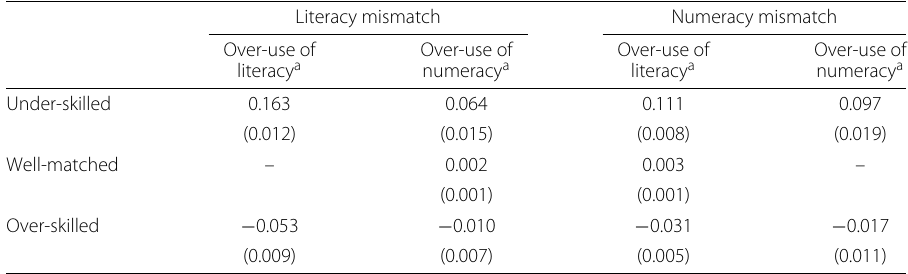
Table 9 Skill mismatch and the use of skills at work Literacy mismatch Numeracy mismatch Over-use of Over-use of Over-use of Over-use of literacy a numeracy a literacy a numeracy a Under-skilled 0.163 0.064 0.111 0.097 (0.012) (0.015) (0.008) (0.019) Well-matched – 0.002 0.003 – (0.001)